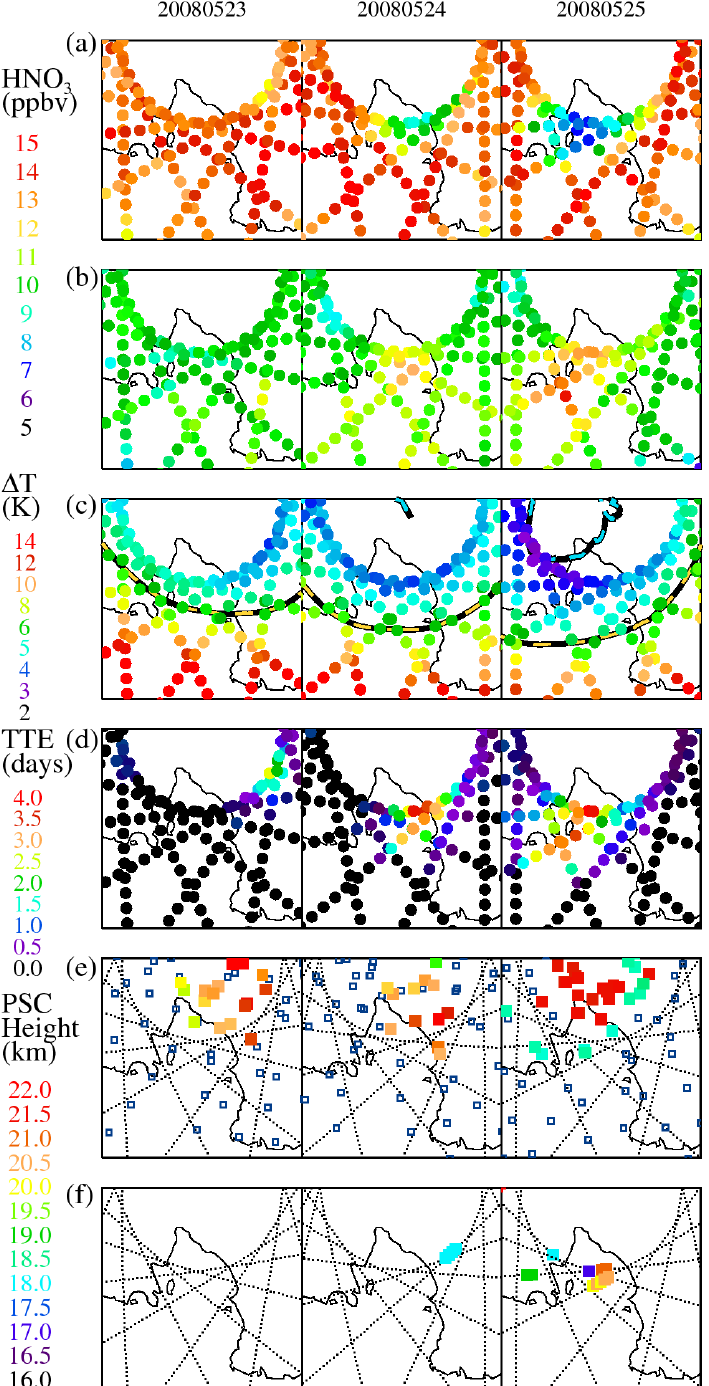
Fig. 6. Orbit plots showing the evolution of HNO 3 , temperature in Kelvin and PSC detections for selected atmospheric levels over a three- day period 23–25 May 2008. The colors in the orbit maps refer to the colored numerical scales given on the left of the figure. (a) MLS 46hPa (20km) HNO 3 . (b) MLS 68hPa (18km) HNO 3 . (c) Temperature relative to the ice frost point, 1T = T − T ICE , on the 46hPa pressure surface (yellow-black and cyan-black dashed contours indicate the T NAT threshold and T STS formation temperatures, respectively). (d) Temperature threshold exposure in days (TTE) for T − T ICE < 5K on the 46hPa pressure surface. (e) MIPAS PSC top heights (open grey squares are MIPAS observations without PSC detections, and small black dots show the Aura orbit tracks). (f) CALIOP PSC top heights (small black dots are CALIOP observations without PSC